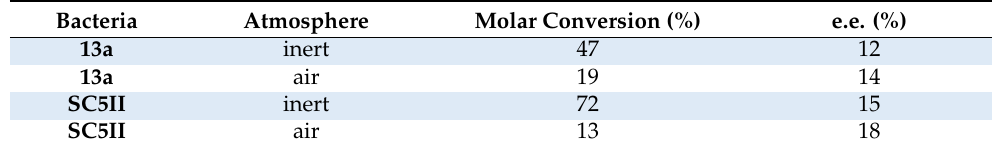
Table 1. Catalytic reactions under an inert atmosphere in comparison to an air one. The enantiomeric excess was evaluated by HPLC equipped with chiral column (Lux Cellulosa 4) [14].